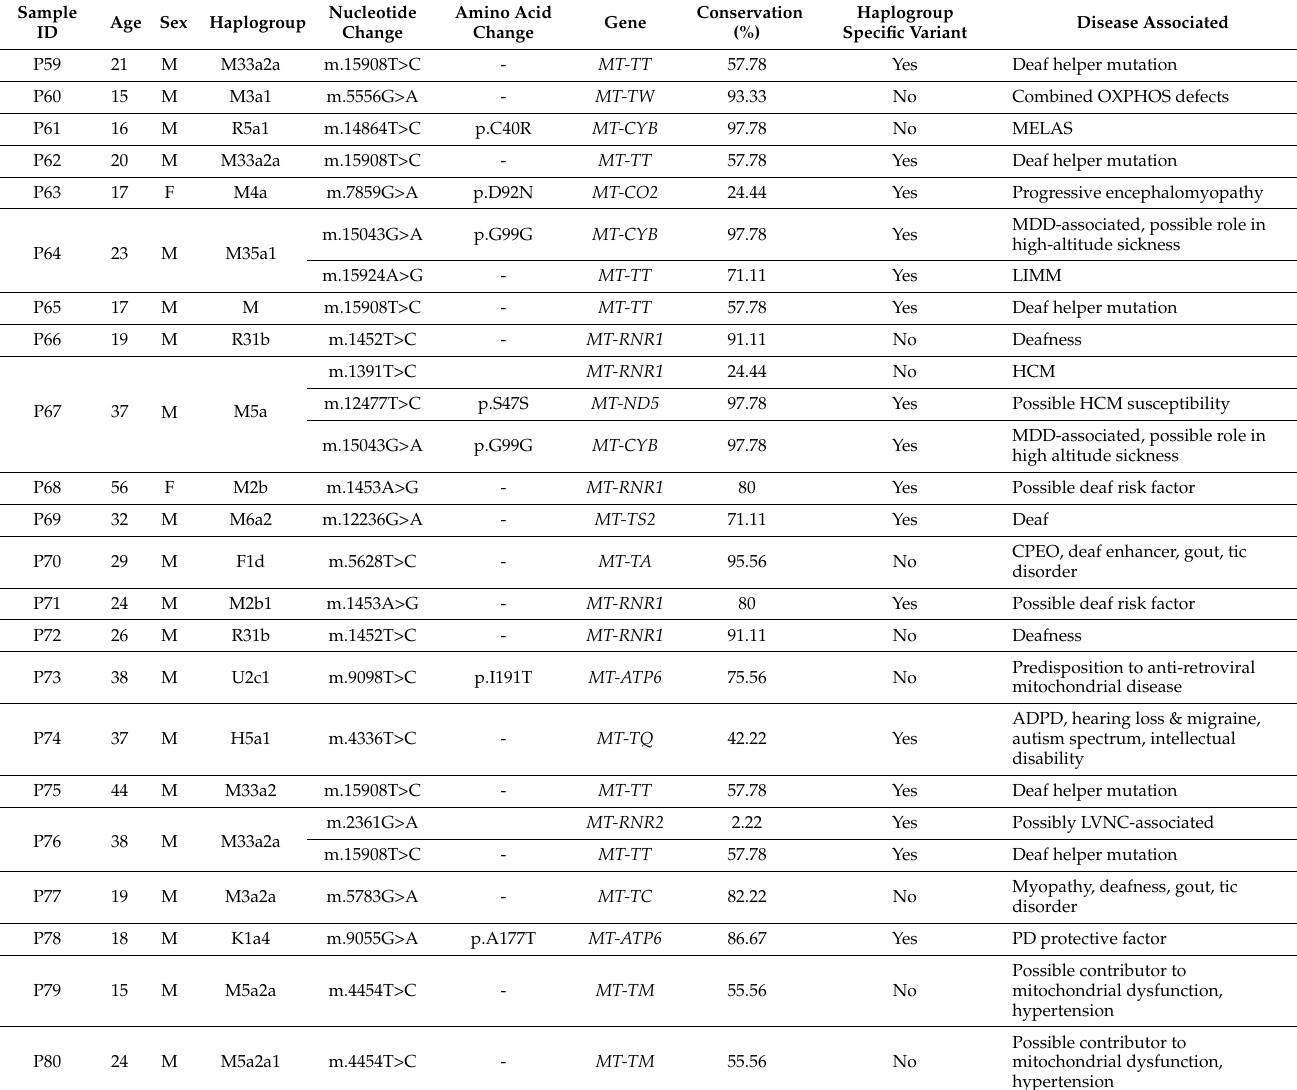
Table 5. Other disease-associated variants in